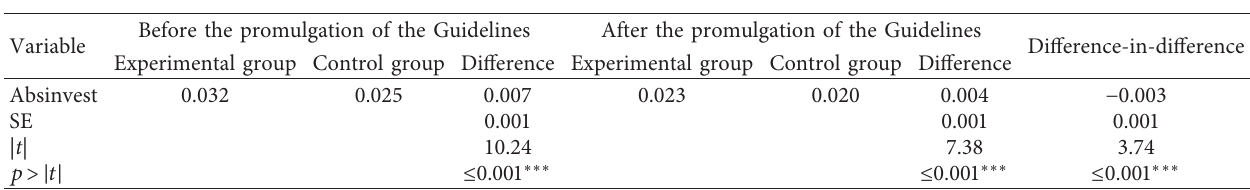
Table 11: Robust test